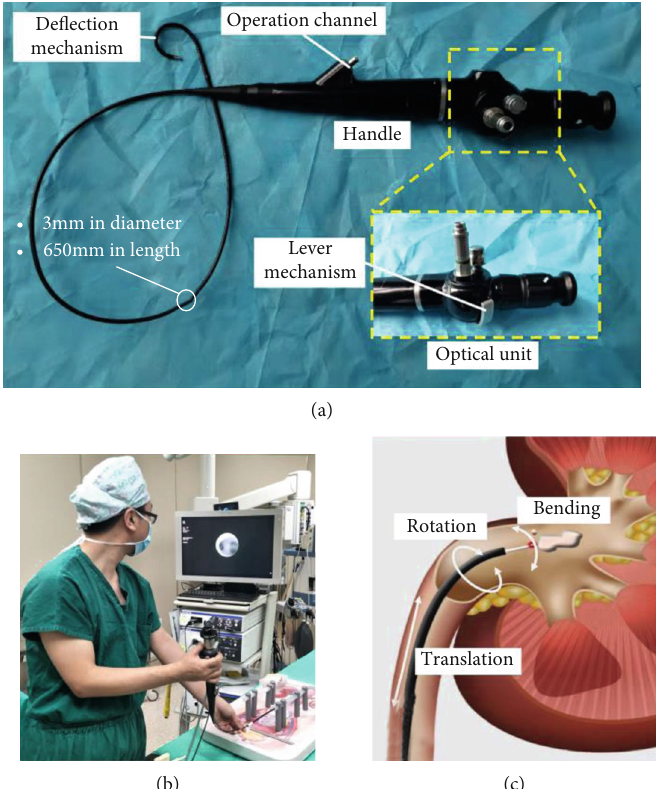
Figure 2: (a) Components of a commercial fl exible ureteroscope; (b) the conventional manual FURS in a standing operation mode; (c) the typical three DoFs of the fl exible ureteroscope, including translation, rotation, and distal